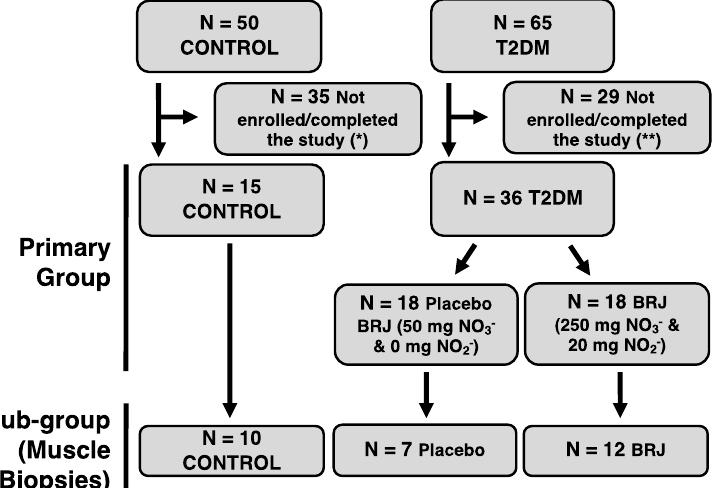
Figure 1. Consort diagram. Diagram illustrating enrollment of patients with type 2 diabetes mellitus (T2DM) and non-diabetic control participants for the entire study (Primary group). The number of participants that provided muscle biopsies (Sub-group) is also shown. (*) Non-diabetic control subjects that did not participate in the study included 11 subjects who did not qualify based on screening questionnaire (either because of too much regular exercise, specific medications, or other studies they were enrolled in), 2 subjects because bifurcation of their brachial artery was identified via Doppler examination and 22 subjects that were either out of contact or did not match to our diabetic population. (**) T2DM patients that did not participate in the study included 5 subjects because of medications used, 1 subject because of chronic kidney disease, 1 subject because of current smoking status, 1 subject misdiagnosed with T2DM, 2 subjects because their body mass index was too high, 14 subjects out of contact or declining to participate prior to consenting, 4 subjects who did not complete the entire study and 1 subject who did not reach VO 2 max in one of the exercise capacity evaluations. The 36 T2DM patients enrolled in the study were assigned via random number generator to receive either placebo or nitrate/nitrite supplementation with a one-to-one allocation. Note: the final number of participants studied with muscle biopsies was influenced by: (i)